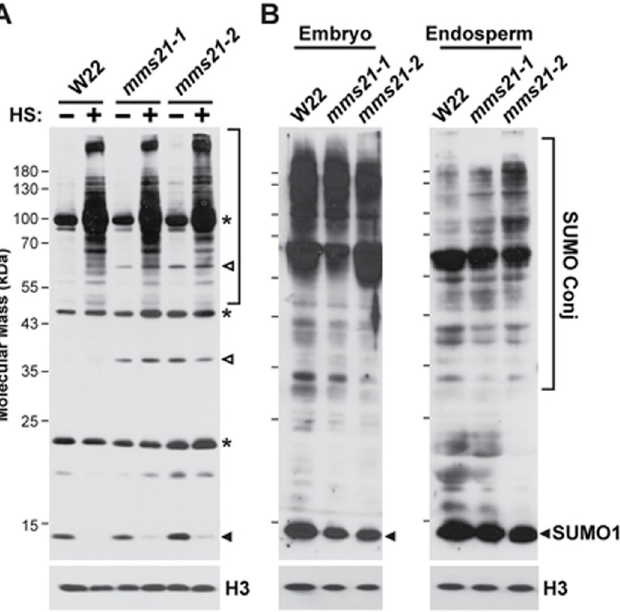
Fig 4. Profiles of SUMO and SUMO Conjugates are Weakly Altered in mms21 Mutants. Total protein was extracted from the indicated tissues and subjected to SDS-PAGE and immunoblot analysis with anti-SUMO1 antibodies. Near equal protein loading was confirmed by immunoblotting with anti-histone H3 antibodies. Closed arrowheads and brackets locate free SUMO and SUMO conjugates, respectively. Open arrowheads locate proteins that differentially accumulated in the mms21 backgrounds. Asterisks locate unidentified species that react with the anti- SUMO1 antibodies. (A) SUMO conjugates accumulating in seedling leaves before (-) or after (+) a 30-min heat shock at 42˚C. (B) SUMO conjugate profiles in embryo and endosperm tissues collected at 16 DAP.